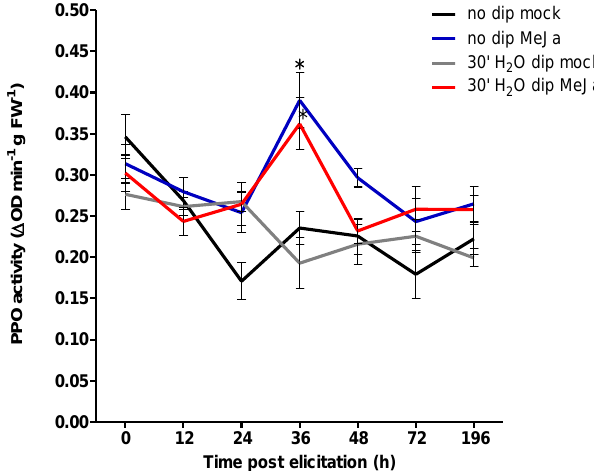
Figure 6. Effect of water dipping treatment on polyphenol oxidase activity. Comparative graph of PPO activity on a time course after MeJA elicitation in water dipped cuttings and non-dipped control cuttings. Basal ends of chrysanthemum cuttings (cv. Baltica), coated with the powder formulated rooting hormone IBA (Chryzotek beige 0.4%), were dipped in water at for 30 min or left untreated. Two weeks after rooting, cuttings were directly harvested for PPO analysis ( t = 0 min) or sprayed with 7.5 mM MeJA to mimic thrips infestation. Mock treated plants served as control. PPO activity was measured in the third leaf from the bottom. Values represent the mean of 10 replicates with SEM. * Asterisks indicate significant difference at α = 0.05 as determined by an unpaired Student’s t -test.